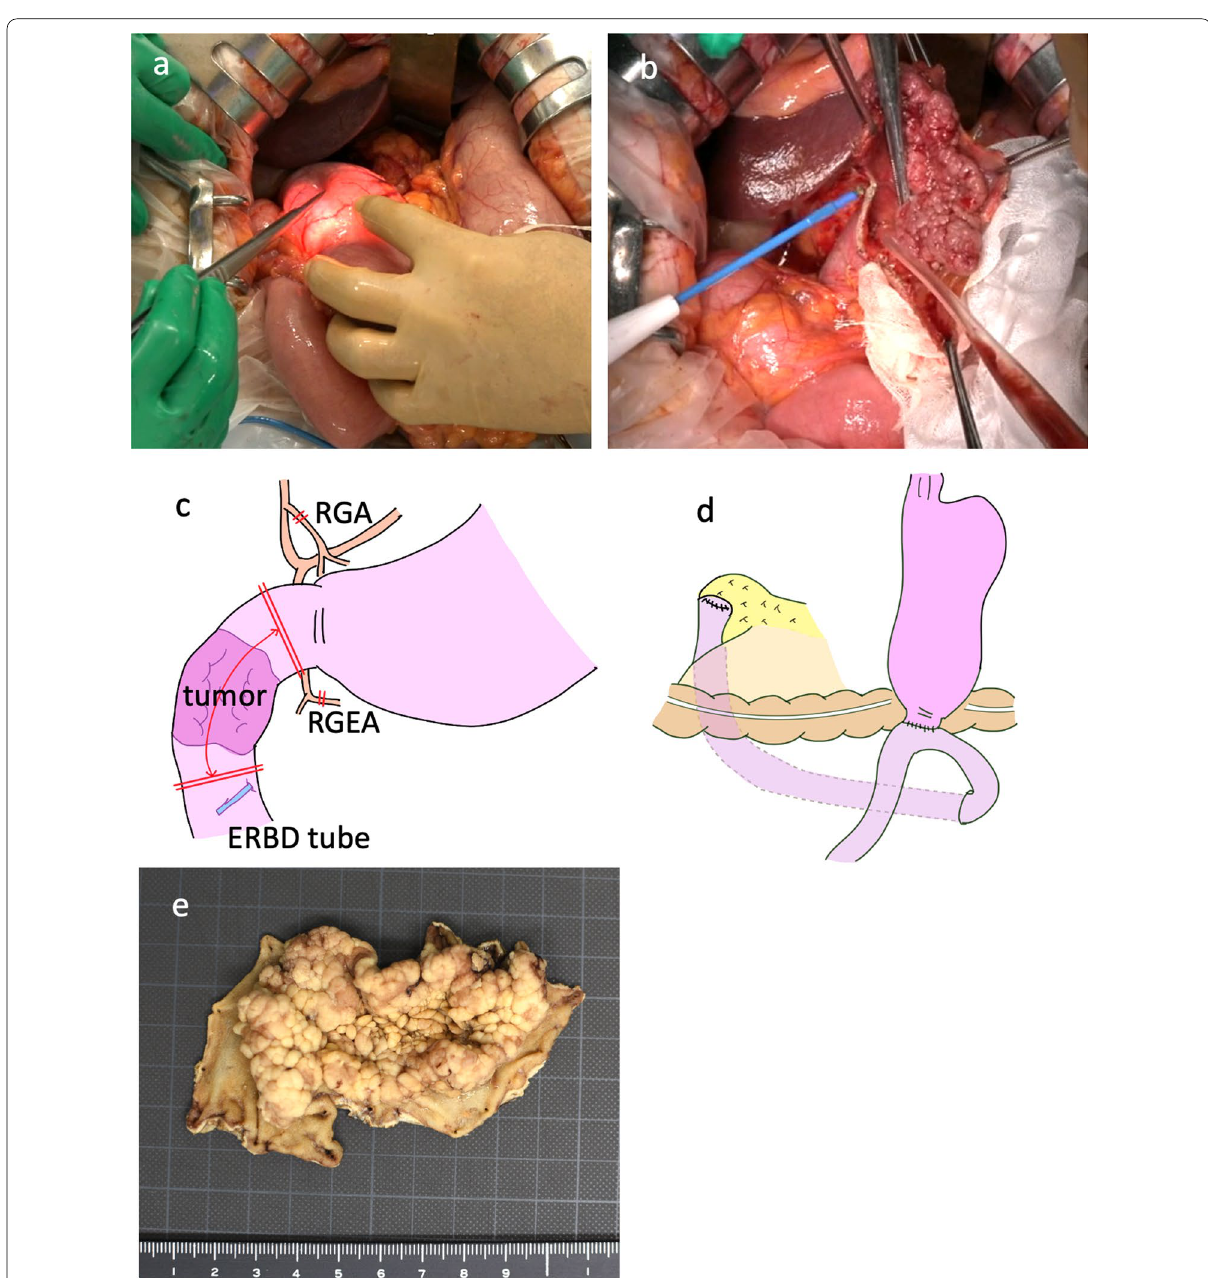
Fig. 2 a The duodenum proximal to the tumor was confirmed using intraoperative endoscopy. b The duodenum distal to the tumor was dissected under direct visualization. c Scheme of surgery. RGA right gastric artery, RGEA right gastroepiploic artery, ERBD endoscopic retrograde biliary drainage. d Scheme of reconstruction. e The specimen showed a papillary tumor 75 mm in